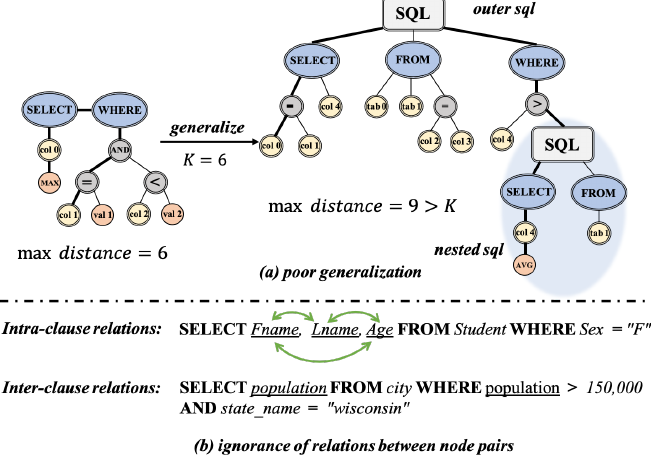
Figure 1. Two major problems incurred by the previous sparse Graph2Seq model. Examples are selected from dataset Spider. ( a ) Poor generalization problem. K is the iteration number. Bold edges indicate the maximum distance between node pairs in the entire graph. ( b ) Ignorance of relations between node